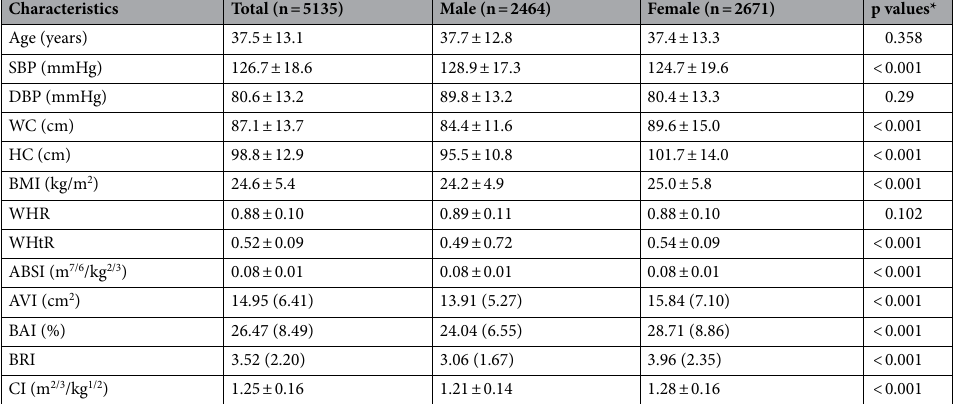
Table 1. Baseline characteristics and anthropometric measurements and indices in the study population. SBP systolic blood pressure, DBP diastolic blood pressure, WC waist circumference, BMI body mass index, WHR waist-to-hip ratio, WHtR waist to height ratio, ABSI a body shape index, AVI abdominal volume index, BAI body adiposity index, BRI body roundness index, CI conicity index. *Comparison between gender; data presented as mean ± standard deviation or median (interquartile